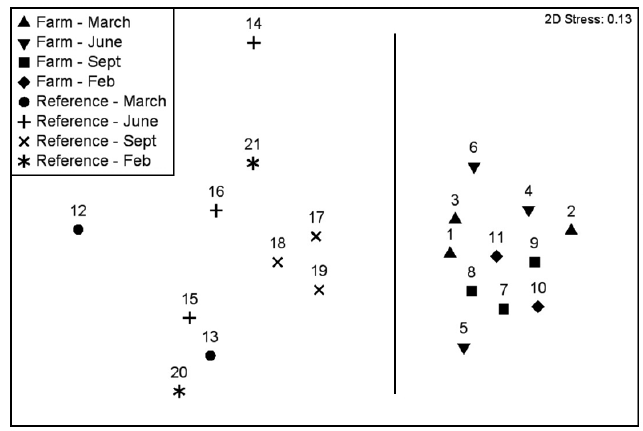
Fig. 2. Multidimensional scaling plot of infauna community com- position at the farming and reference locations at different